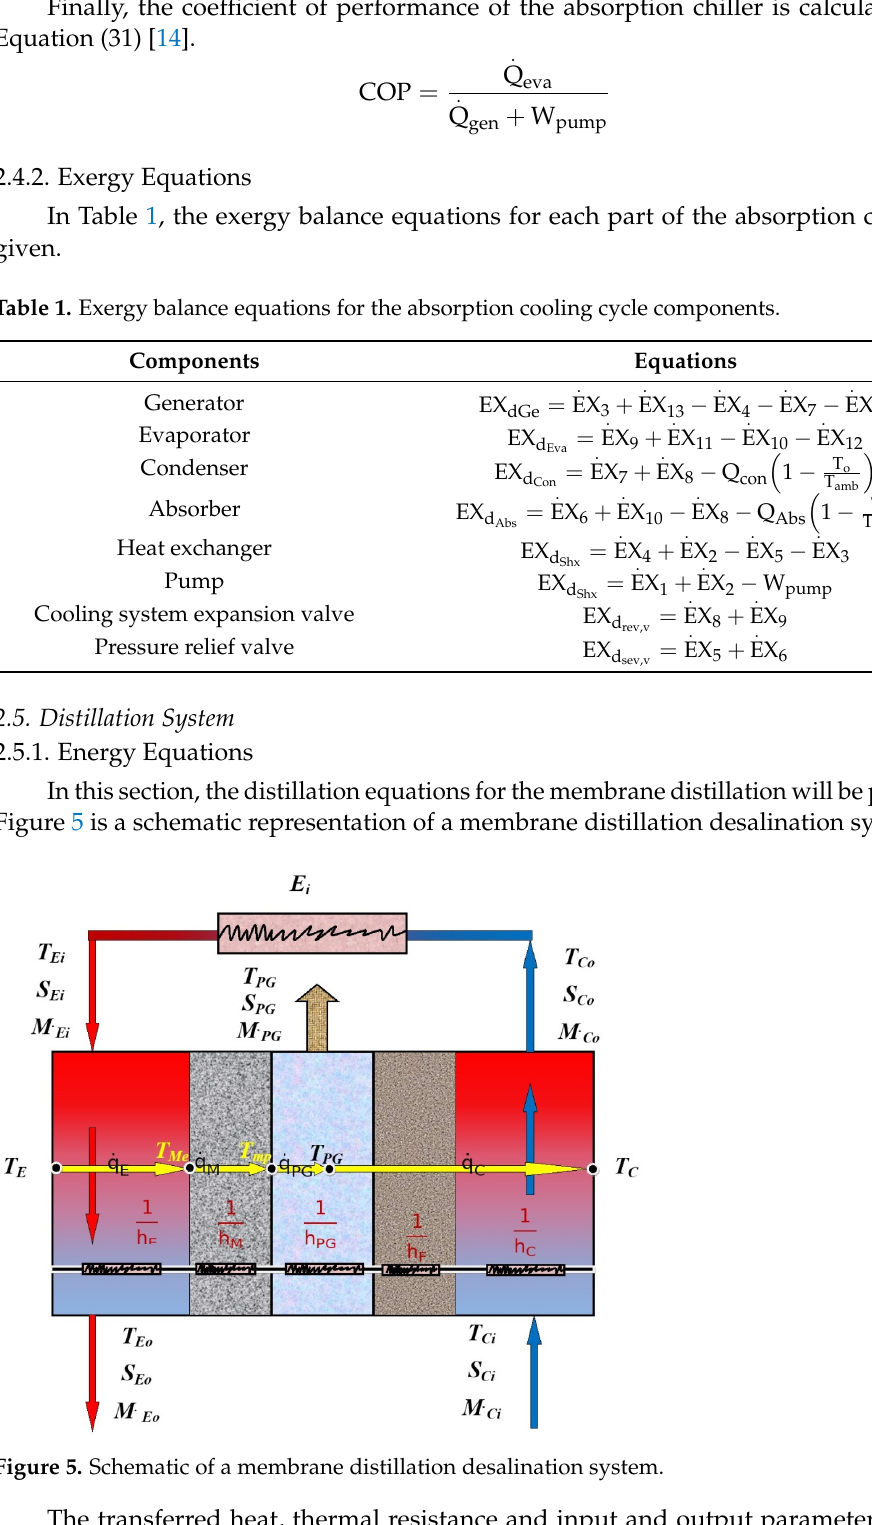
Table 1. Exergy balance equations for the absorption cooling cycle components.